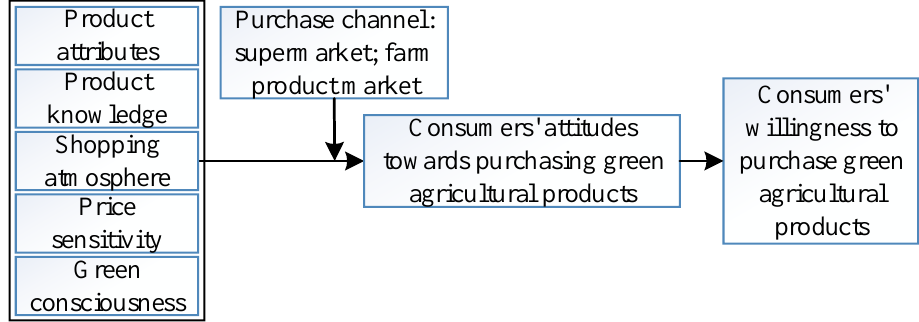
Figure 8. Theoretical Model.